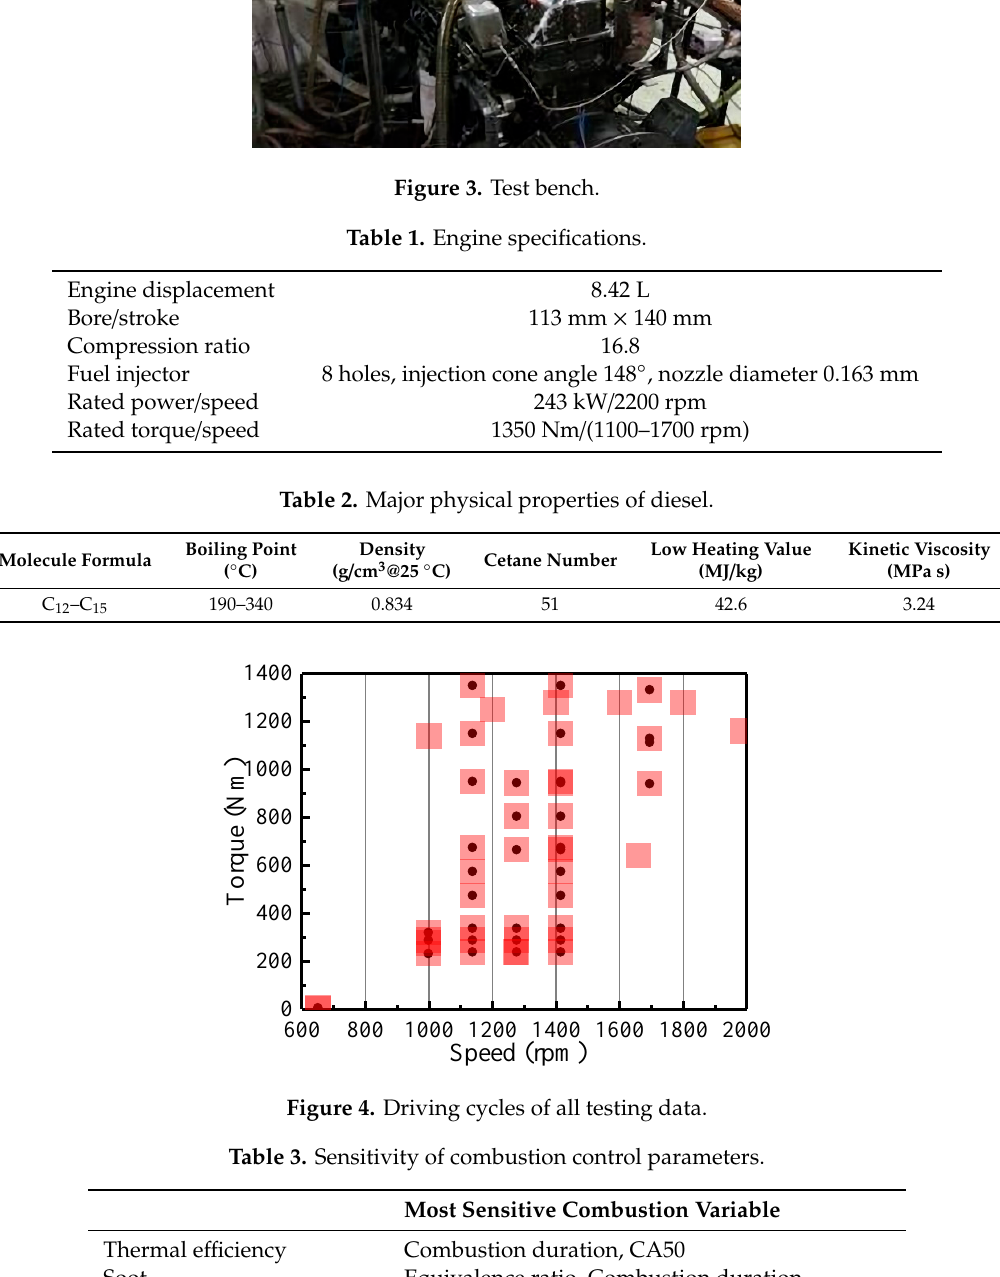
Table 3. Sensitivity of combustion control parameters. Most Sensitive Combustion Variable Thermal efficiency